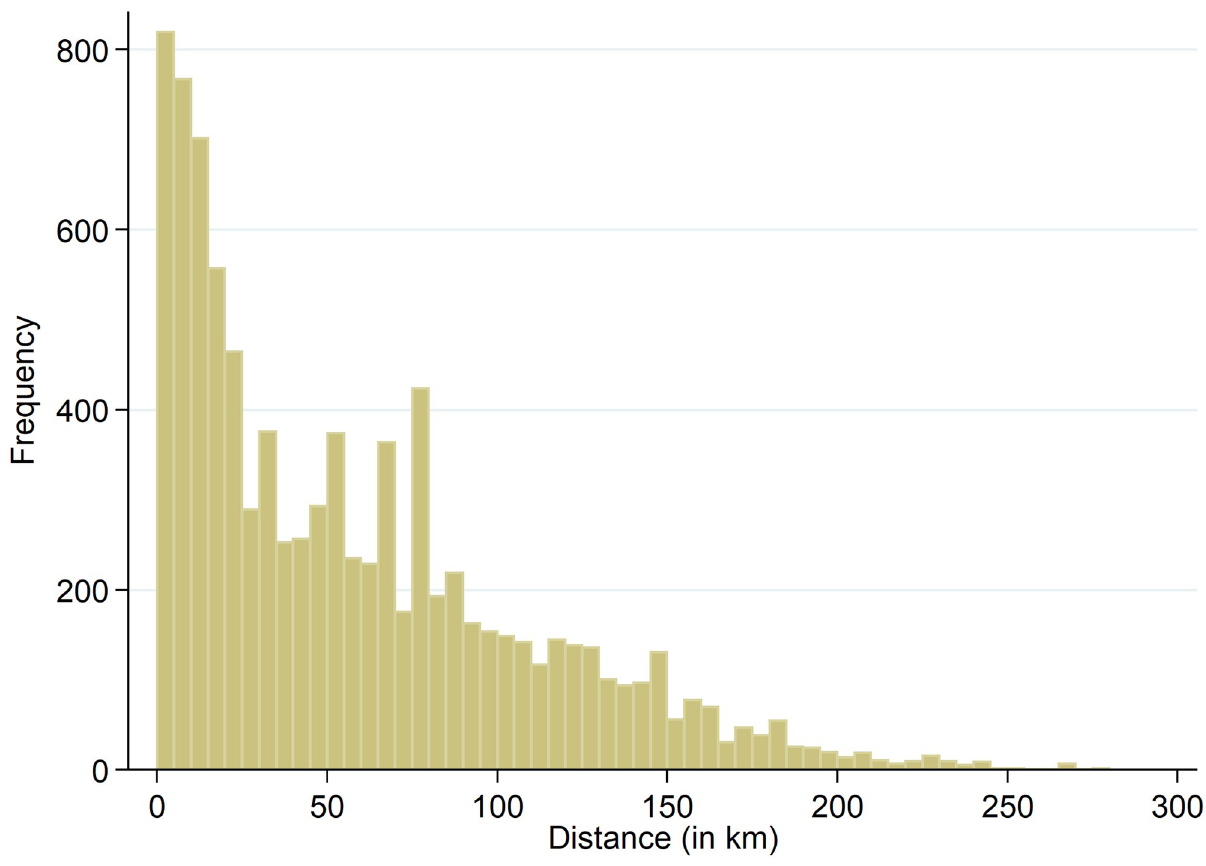
Fig 5. Non-zero distances between full-IP and anonymized geolocations at session level.